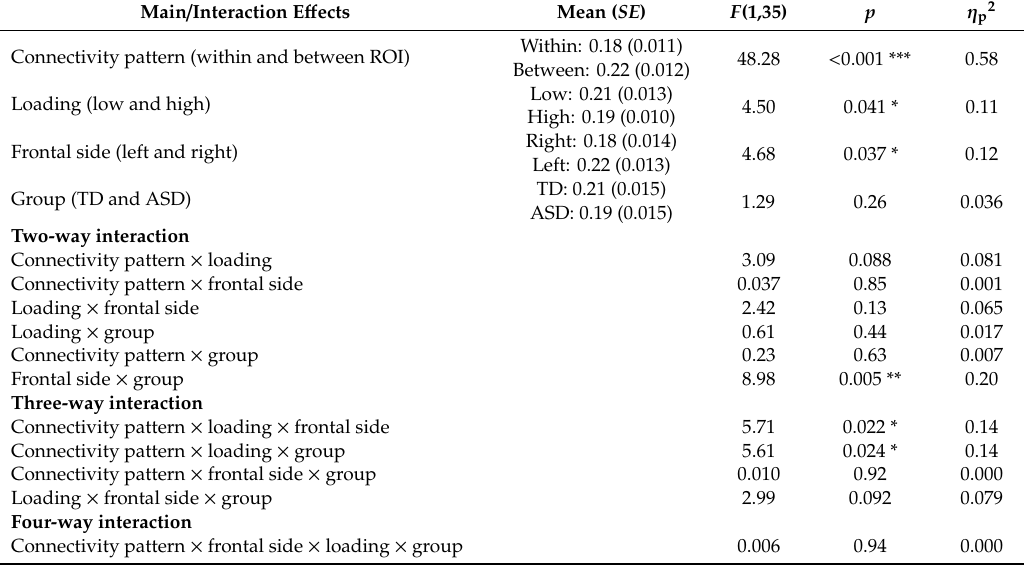
Mixed ANOVA (group × loading × frontal side × connectivity pattern) results for intrahemispheric connectivity (i.e., mean